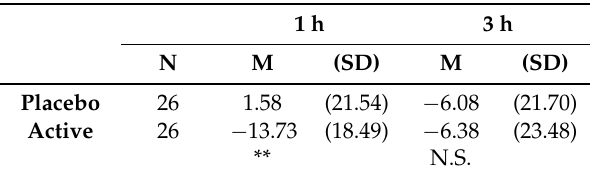
Table 2. Baseline adjusted stress response ( ∆∆ stress, mean and standard deviation) to the multi-tasking framework (MTF) at both post-dose assessments for placebo and active treatments.